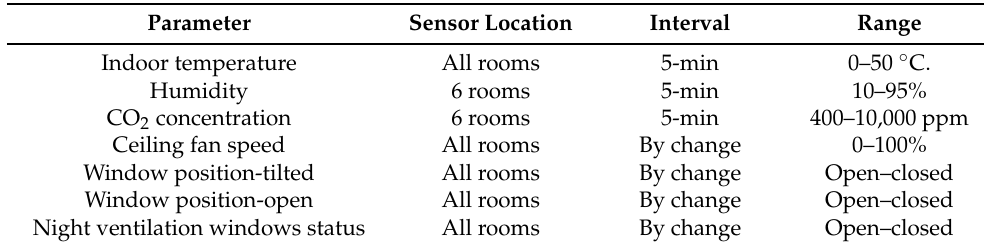
Table 4. Overview of monitoring data: measured parameters, sensor location, measurement interval and